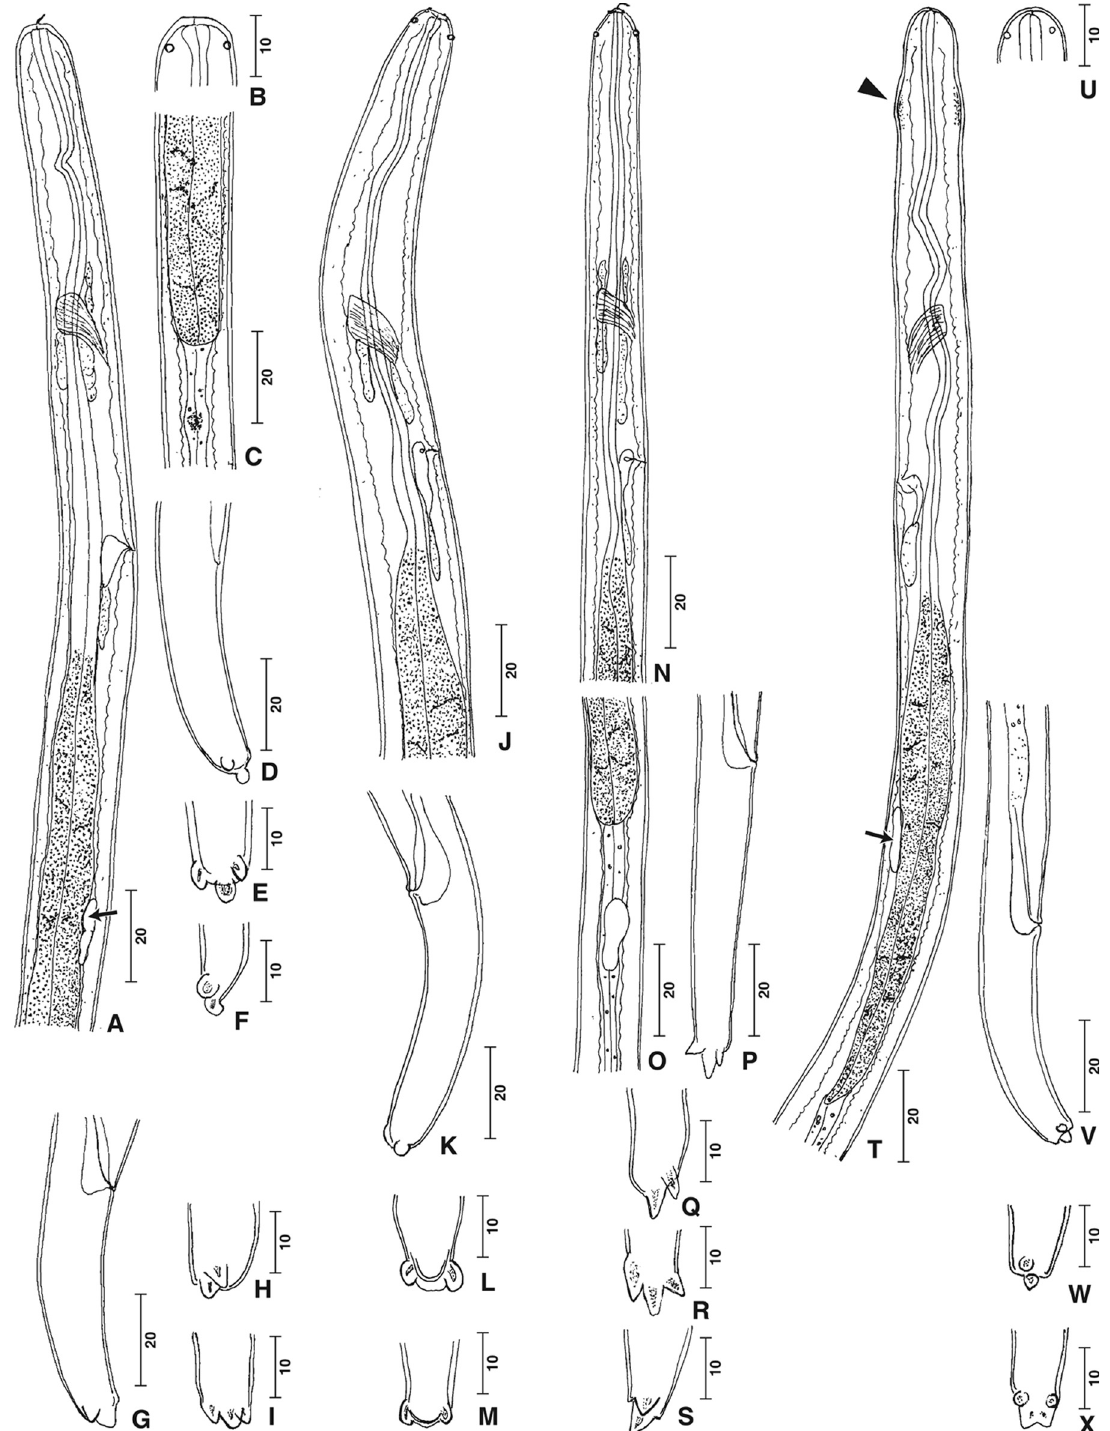
Figure 1. Infective larvae of Cercopithifilaria species from ticks collected from the Japanese serow. (A–F) Type A larva . A. Anterior part, right lateral view. Female genital primordium, arrow. B. Head. C. Oesophageal-intestinal junction. D. Tail, right lateral view at anus. E. Caudal end, ventral view. F. Caudal end, left lateral view. (G–I) Type B larva . G. Tail, right lateral view. H. Caudal end, lateral view. I. Caudal end, ventral view. (J–M) Type C larva . J. Anterior part, right lateral view. K. Tail, left lateral view. L-M. Caudal end, ventral view. (N–S) Type D larva . N. Anterior part, right lateral view. O. Oesophageal-intestinal junction. *Male genital primordium. P. Tail, right lateral view at anus; ventral view at the end. Q. Caudal end, right lateral view. R. Caudal end, ventral view. S. Caudal end, left lateral view. (T–X) Type E larva . T. Anterior part, left lateral view. Cervical swelling, arrowhead; female genital primordium, arrow. U. Head. V. Tail, right lateral view. W. Caudal end, lateral view. X. Caudal end, ventral view. Scale bars: